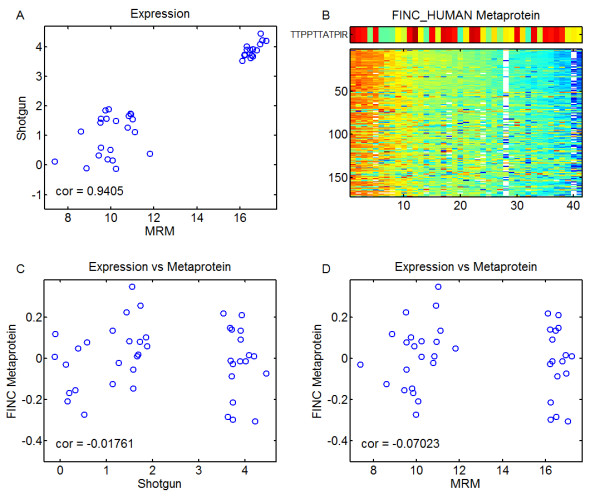
Verification of poor coherence. Peptide that doesn’t follow the pattern of it’s dominant metaprotein. Panel a shows the correlation between the measured intensity of the polypeptide TTPPTTATPIR from the label-free, unbiased platform compared to the label-free SRM platform. The high level of correlation demonstrates the reproducibility of measurement of this peptide. Panel b shows the pattern of expression, as measured in the unbiased platform, as compared to the pattern of expression of the FINC metaprotein. Panel c shows a scatterplot comparing the pattern of expression of the FINC metaprotein and the intensity of the peptide as measured with the shotgun approach and panel d shows the same comparison, but now with the SRM approach instead of the shotgun approach. The peptideis measured consistently and it does not correlate with the expression pattern of the FINC metaprotein.